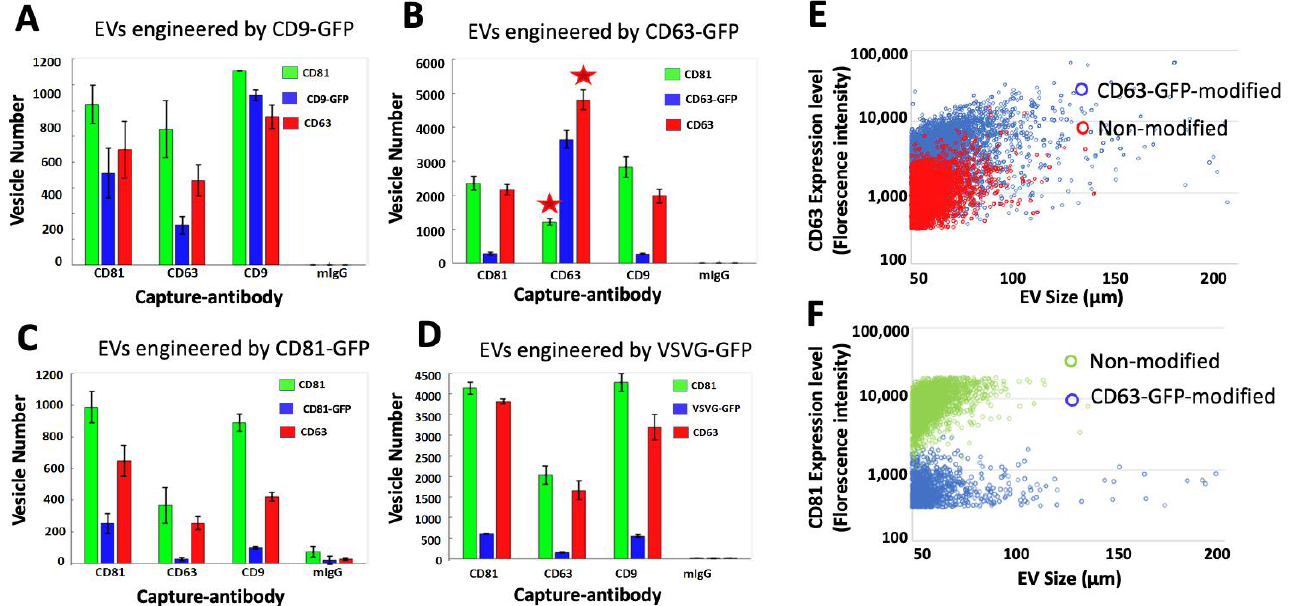
Figure 6. Effects of the engineering scaffolds on the expression of EV surface markers. ( A – D ) EVs captured on-chip by monoclonal antibodies to CD9/CD63/CD81 were further characterized for their expression of the GFP-tagged engineering scaffolds (blue) as well as CD63 and CD81, which are detected by the fluorescein CF647-labeled anti-CD63 antibody (red) and the CF555-labeled anti- CD81 antibody (green). The number of EVs that express these markers was analyzed and graphed. ( E , F ) Scatter plots comparing the expression levels of surface markers in CD63-GFP-modified vs. non-modified EVs. Blue dots represent CD63-GFP-EVs and red dots represent non-labeled EVs ( E ); Blue dots represent CD63-GFP-EVs and green dots represent non-labeled EVs ( F ).